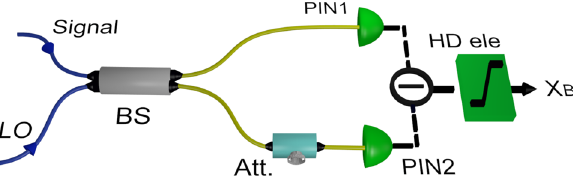
Figure 6. Balanced homodyne detection. An attenuator (Att) in one of the output port of 50/50 beamsplitter (BS) balances the photo current generated from photodiodes PIN1 and PIN2. Homodyne electronics circuit amplifies the subtracted photo